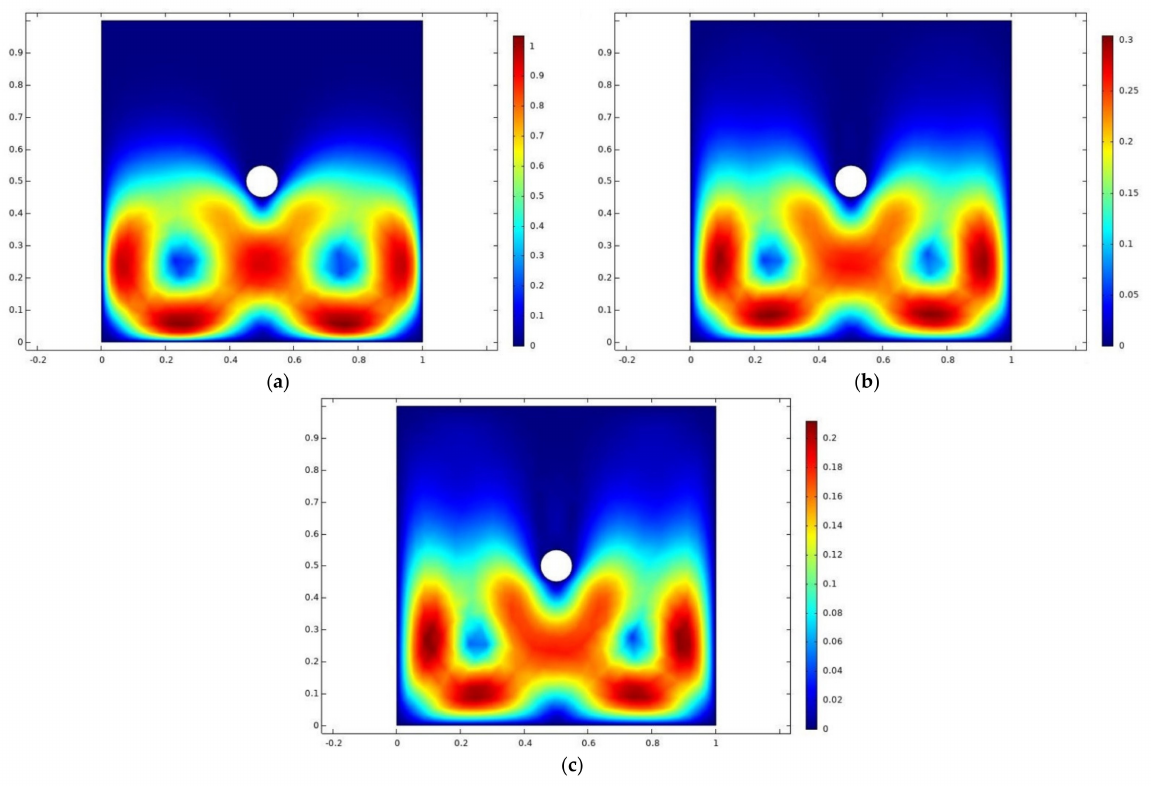
Figure 3. Impact of power-law index ( n ) on velocity distribution. ( a ) ( n = 0.5), ( b ) ( n = 1), ( c ) ( n =